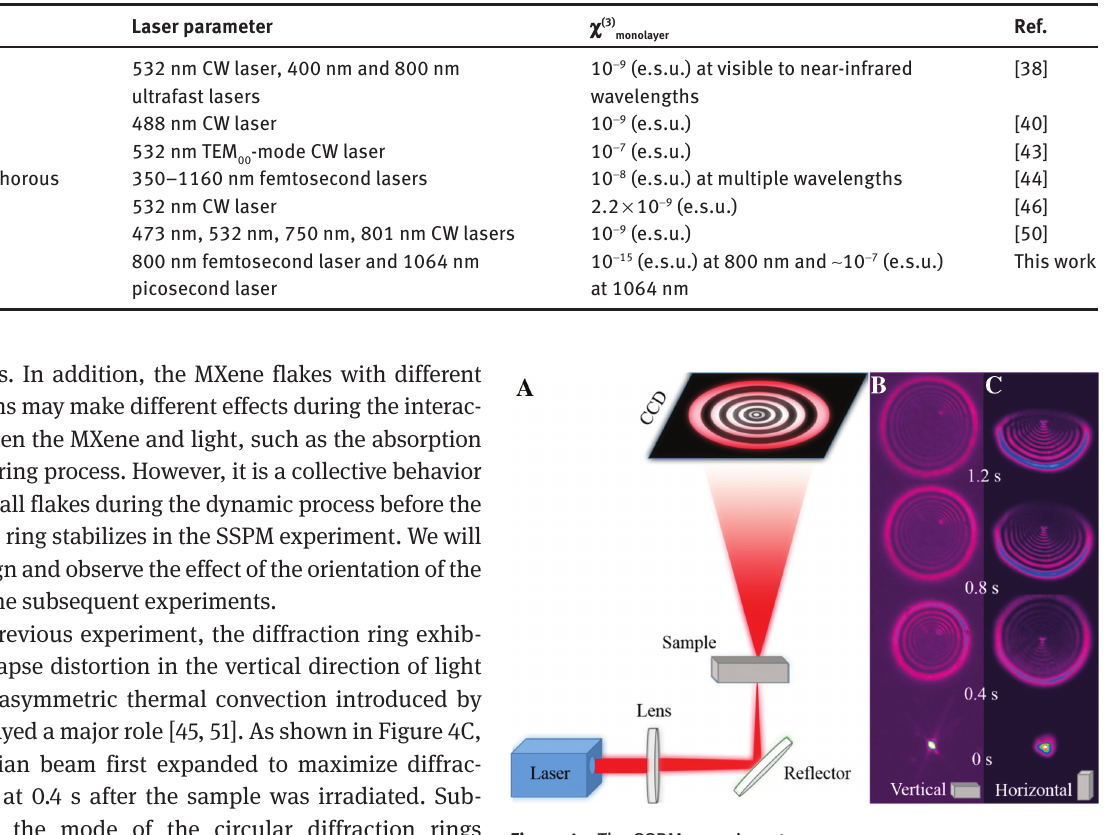
Figure 4: The SSPM experiments. (A) Schematic diagram of the SSPM experimental setup with the sample placed horizontally. (B, C) Snapshots of the pattern formation at 800 nm